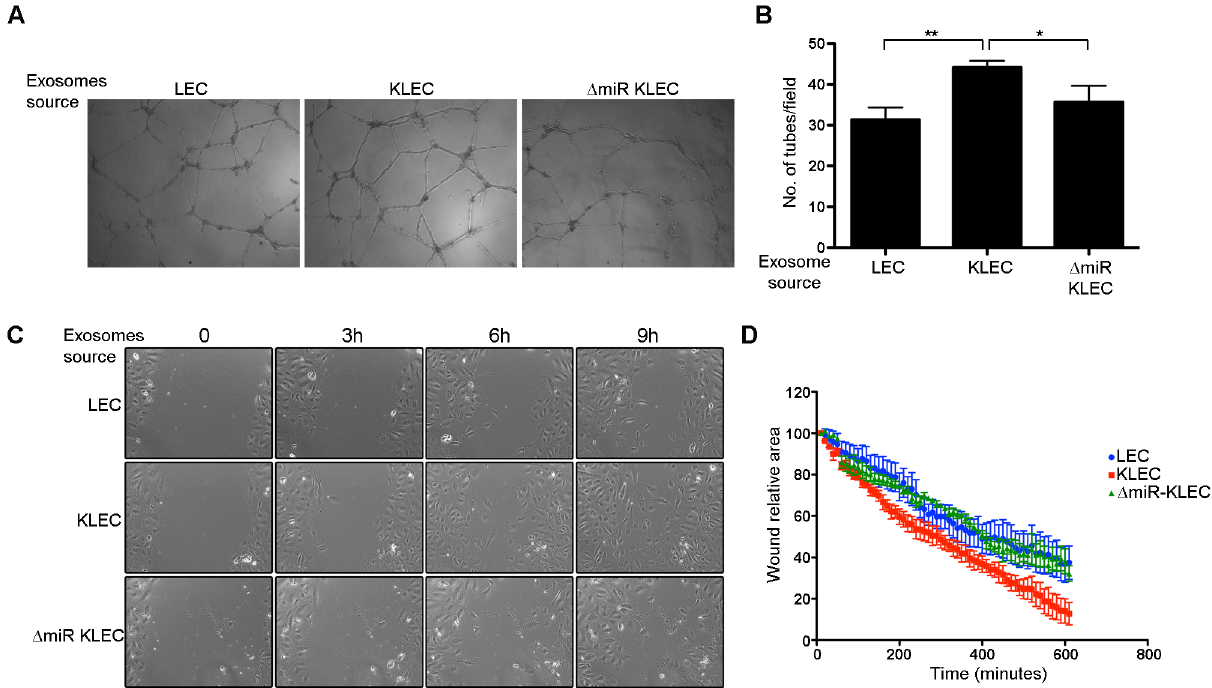
Fig 6. KLEC-derived exosomes increasethe angiogenic potential and migration of non-infected endothelial cells. (A-B) 10 5 LEC were educatedusing 2.5x10 9 LEC, KLEC or Δ miR-KLEC—derived exosomes. Angiogenicpotential was measuredusing an endothelialcell tube-formation assay. (A) Representative images of tubes formed on matrigel. (B) Average number of tubes per field acquired.The graph presents the mean and standarddeviationof 3 biologicalrepeats. Statistical significancewas denotedby * P < .05, ** P < .01, *** P < .001. (C-D) Cell migrationof educatedHUVEC was measuredusing woundhealingassay (scratch assay). EducatedHUVEC were seeded at 80% confluencein a 24-wellplate and allowedto equilibrateovernight. Once scratched, plates were immediately placed in Nikon Biostation CT or Zeiss Cell Observer and Images were acquiredfor 16 hours. (C) representative images of educatedHUVEC at 0, 3, 6 and 9 hours’ post scratch. (D) Relativescratch area over time as analysedusing ImageJ.